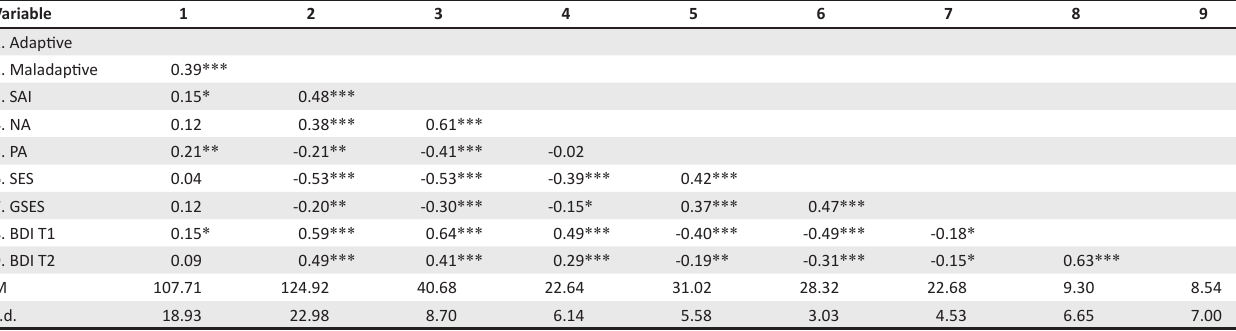
TABLE 1: Correlations and descriptive statistics ( N = 206). Variable